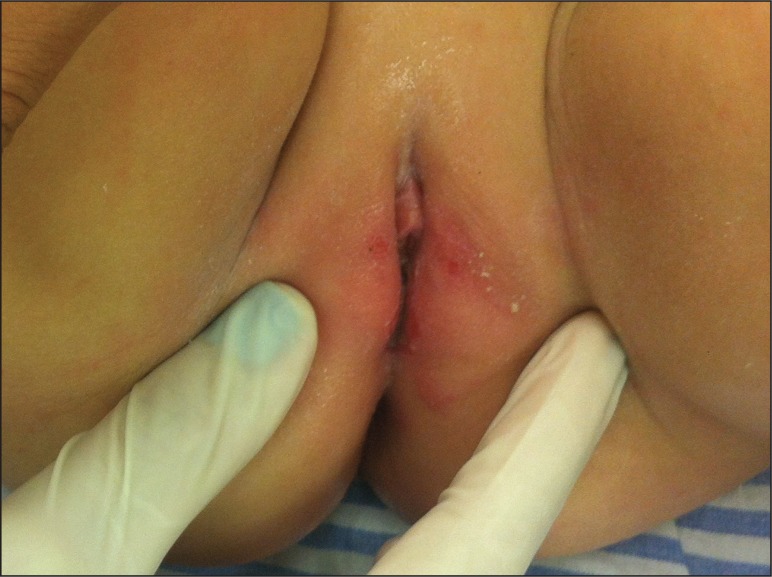
Queimadura na parte externa da região vulvar